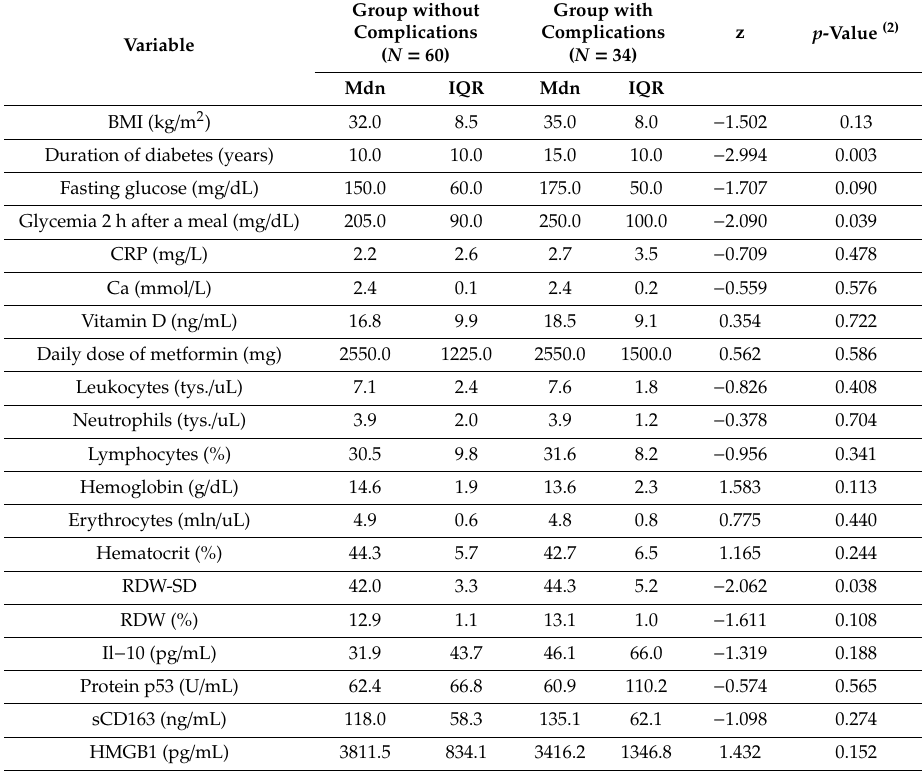
Table 2. Classification of physical chemistry parameters in patients with type 2 diabetes due to cardiovascular complications. Frequency analysis of quantitative variables. Non-parametric analysis with the Mann–Whitney U test.